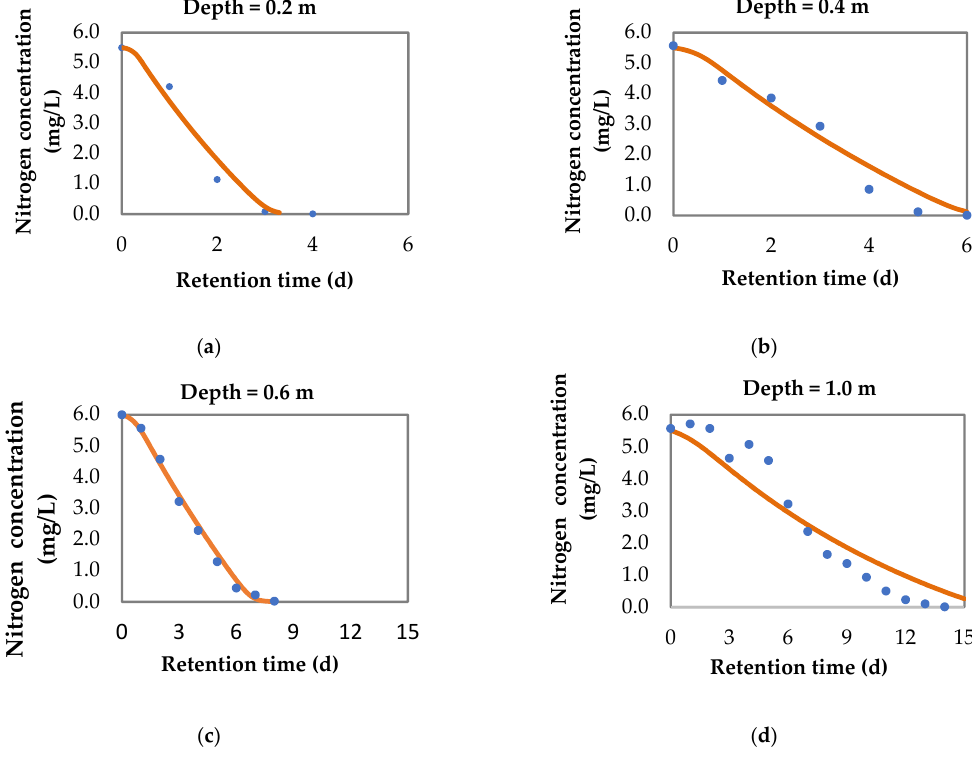
Figure 5. ( a ) Experimental data and simulated curve for nitrogen as function of time for SBPP with a depth of 0.2 m; ( b ): Experimental data and simulated curve for nitrogen as function of time for SBPP with a depth of 0.4 m, ( c ): Experimental data and simulated curve for nitrogen as function of time for SBPP with a depth of 0.6 m, ( d ): Experimental data and simulated curve for nitrogen as function of time for SBPP with a depth of 1.0 m.